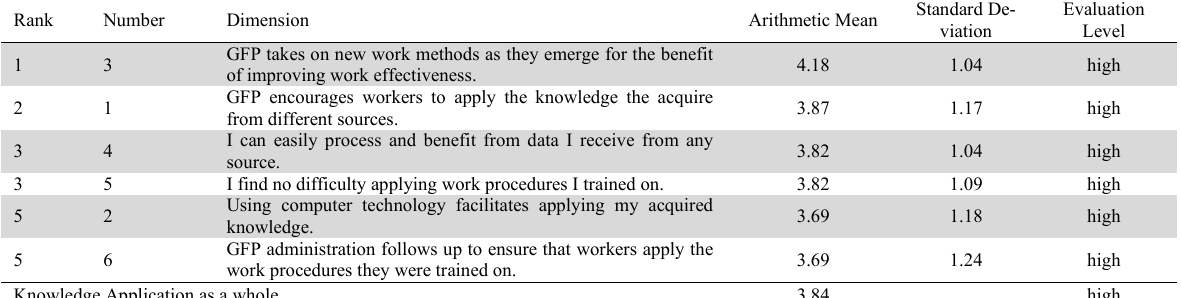
Arithmetic Means and Standard Deviations of Sample Responses to ‘Knowledge Application’ Dimen- sion (in descending order by arithmetic